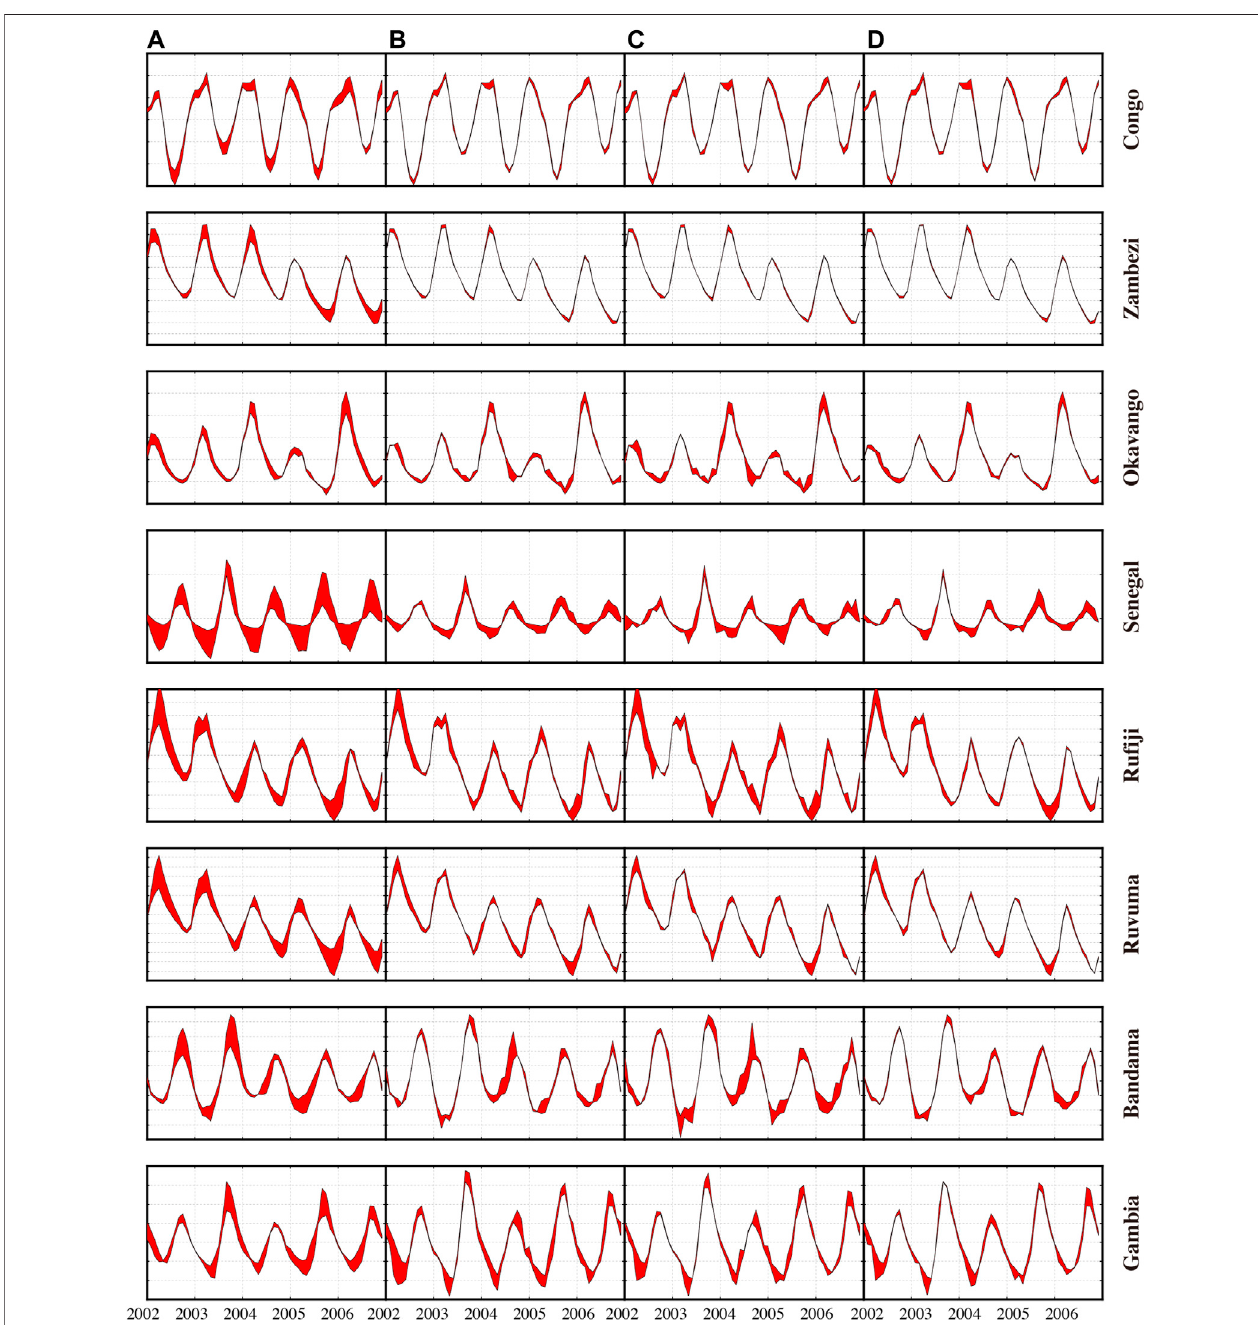
FIGURE8| Fillplots fordifferent approaches over eightAfrica riverbasins: (A) Gaussian fi lters; (B) forward modelingmethod withsimulated GRACE observations; (C) improved forward modeling method with simulated GRACE observations; (D) improved forward modeling method with simulated GRACE Follow-On observations. The ordinate of each subplot is different. The amount of red is the differences between the true time series and the result from corresponding approach. Thus, less red means better performance.